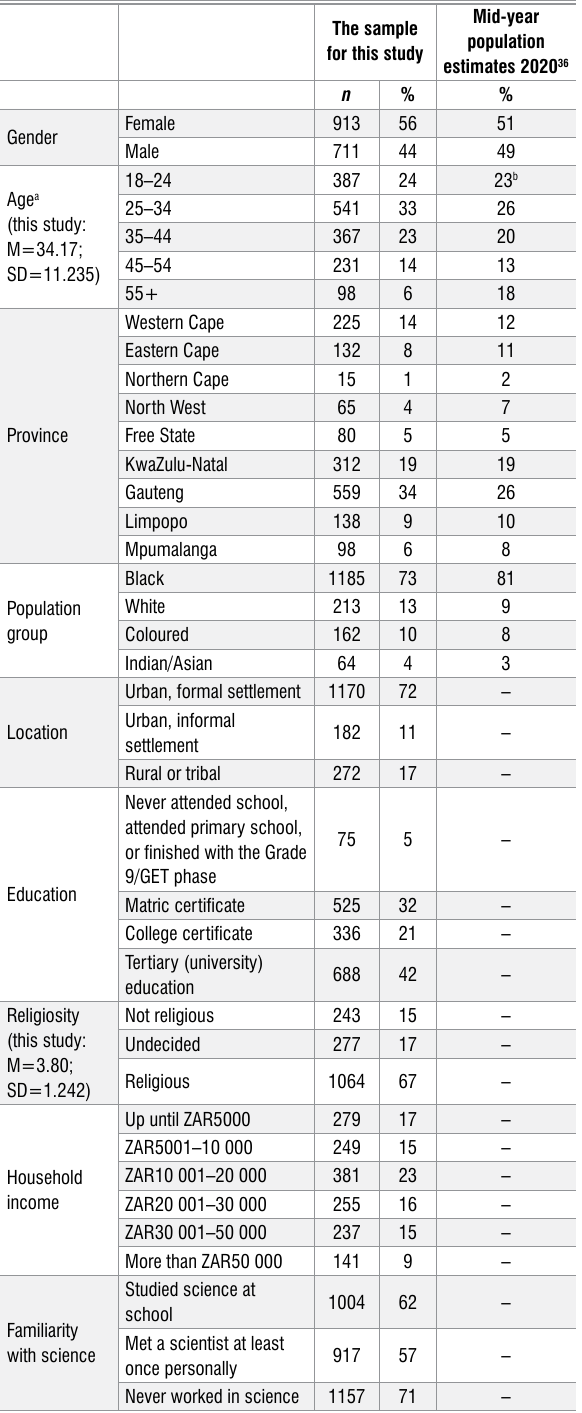
Table 1: Sociodemographic information (frequencies, percentages)